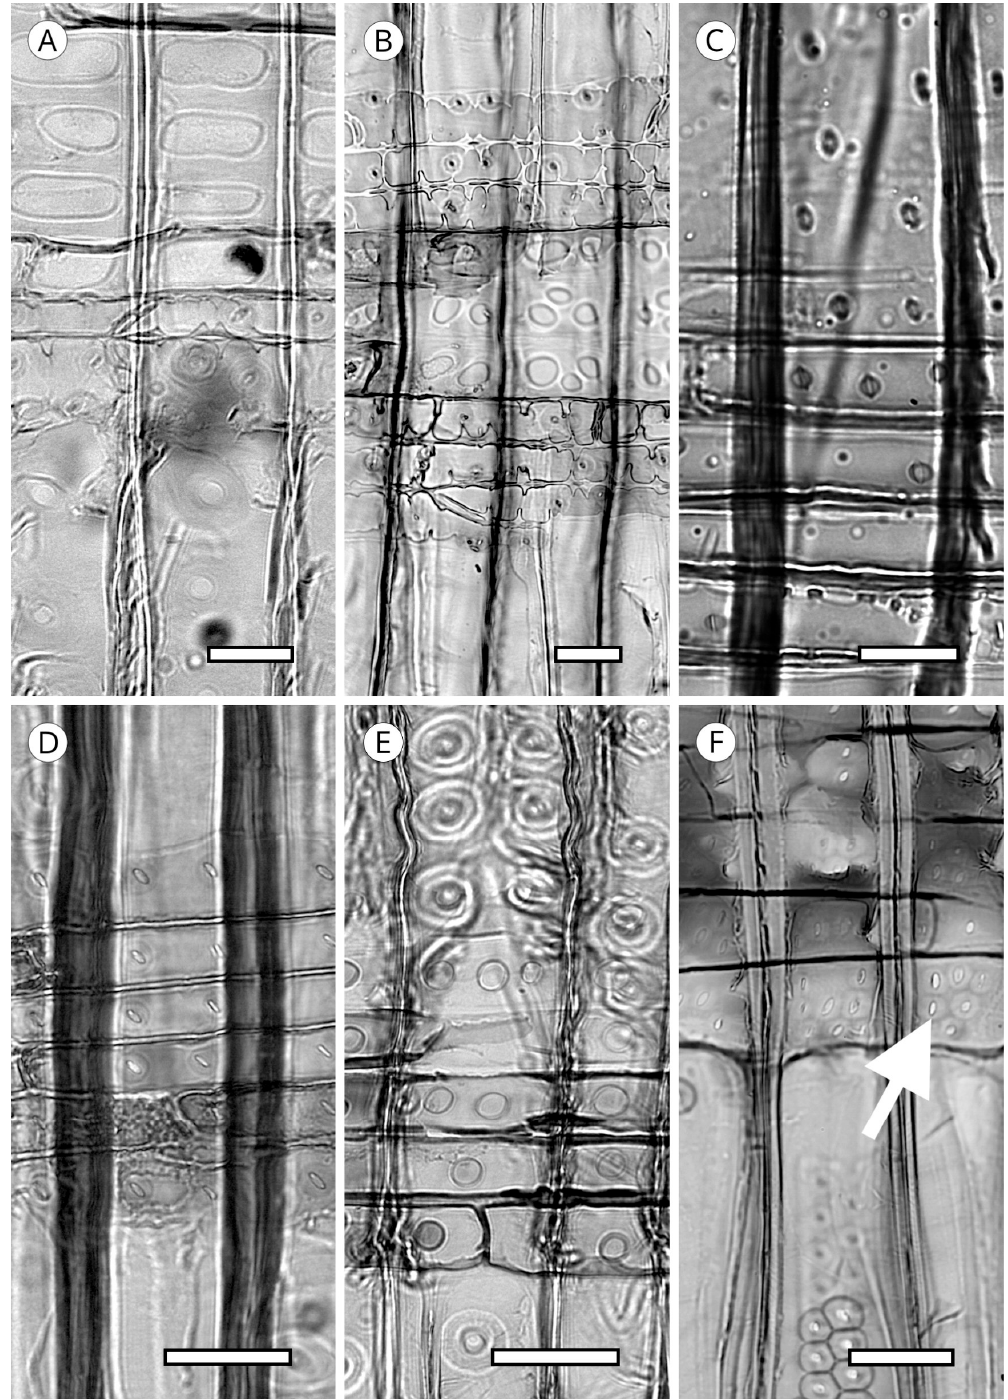
Figure 36. Cross-field pitting. ( A ) Window-like in Pinus resinosa Aiton; ( B ) Pinoid in Pinus arizonica Engelm.; ( C ) Piceoid in Abies cilicica (Antoine & Kotschy) Carrière; ( D ) Cupressoid in Juniperus canariensis , Guyot and Mathou; ( E ) Taxodioid in Metasequoia glyptostroboides , Hu and W.C.Cheng; ( F ) Araucarioid in Araucaria columnaris (G.Forst.) Hook. Scale bars. ( A – F ) = 25 μ m.